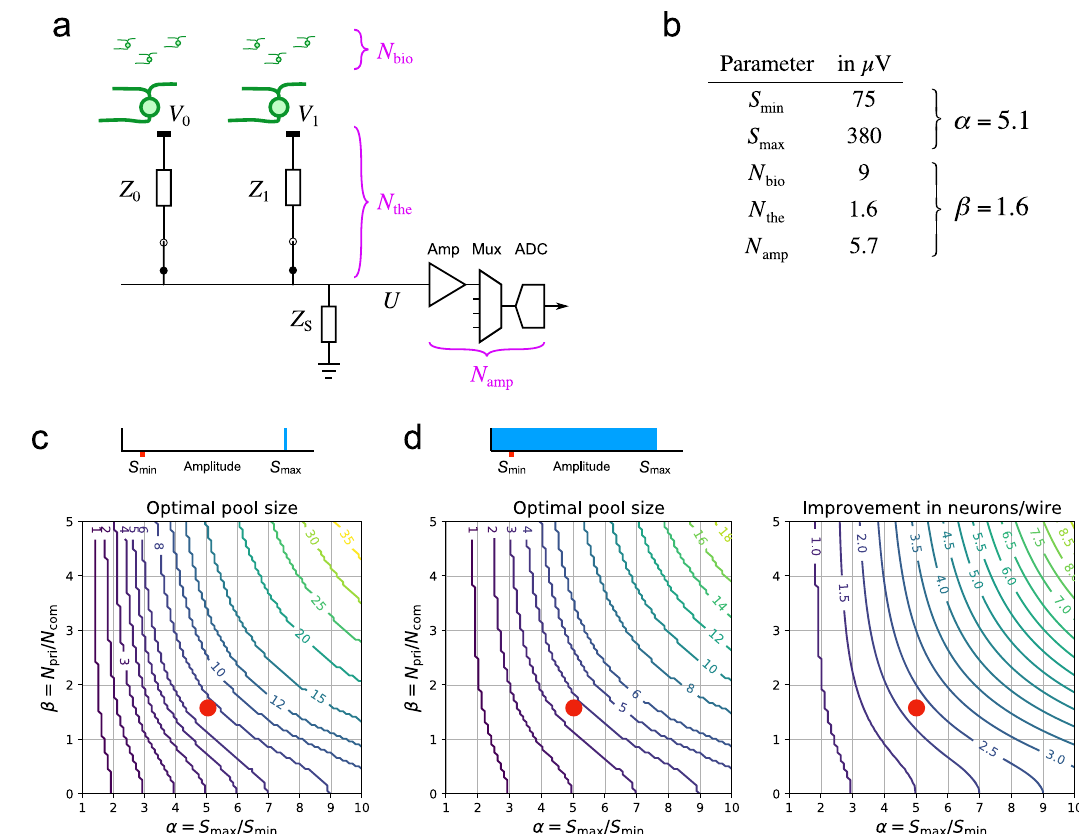
Fig. 2 Pooling of signal and noise. a An idealized circuit for two electrodes connected to a common wire along with downstream components of the signal chain, such as the ampli fi er, multiplexer, and digitizer. Z 0 , Z 1 : total impedance for electrodes 0 and 1, with contributions from the metal/bath interface